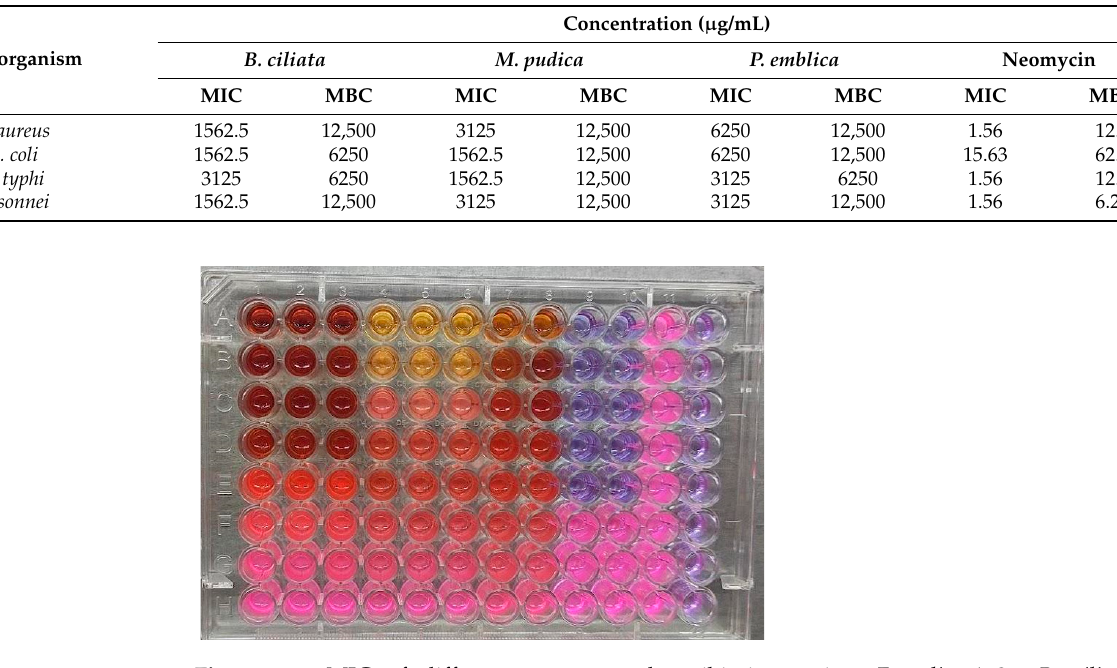
Table 4. Minimum inhibitory and minimum bactericidal concentration of plant extract ethyl acetate fraction.